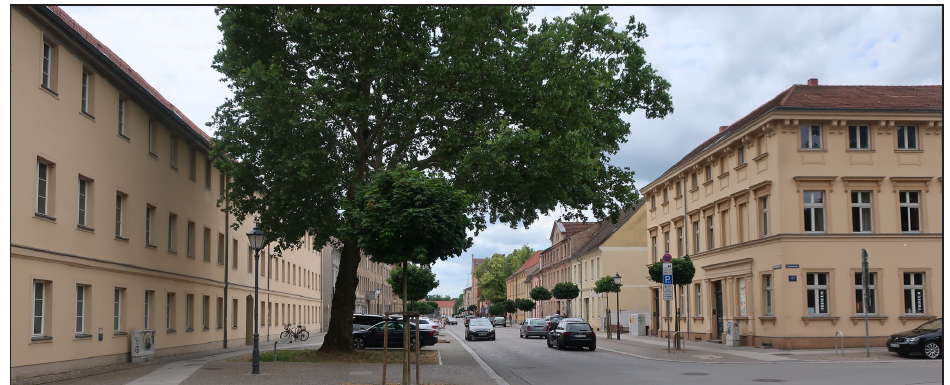
Figure 2: Neuruppin in 2019 still exhibited the principles guiding its rebuilding after 1787: wide streets, open spaces, tile roofs, evenly spaced windows, and the absence of wood. Photographed by the